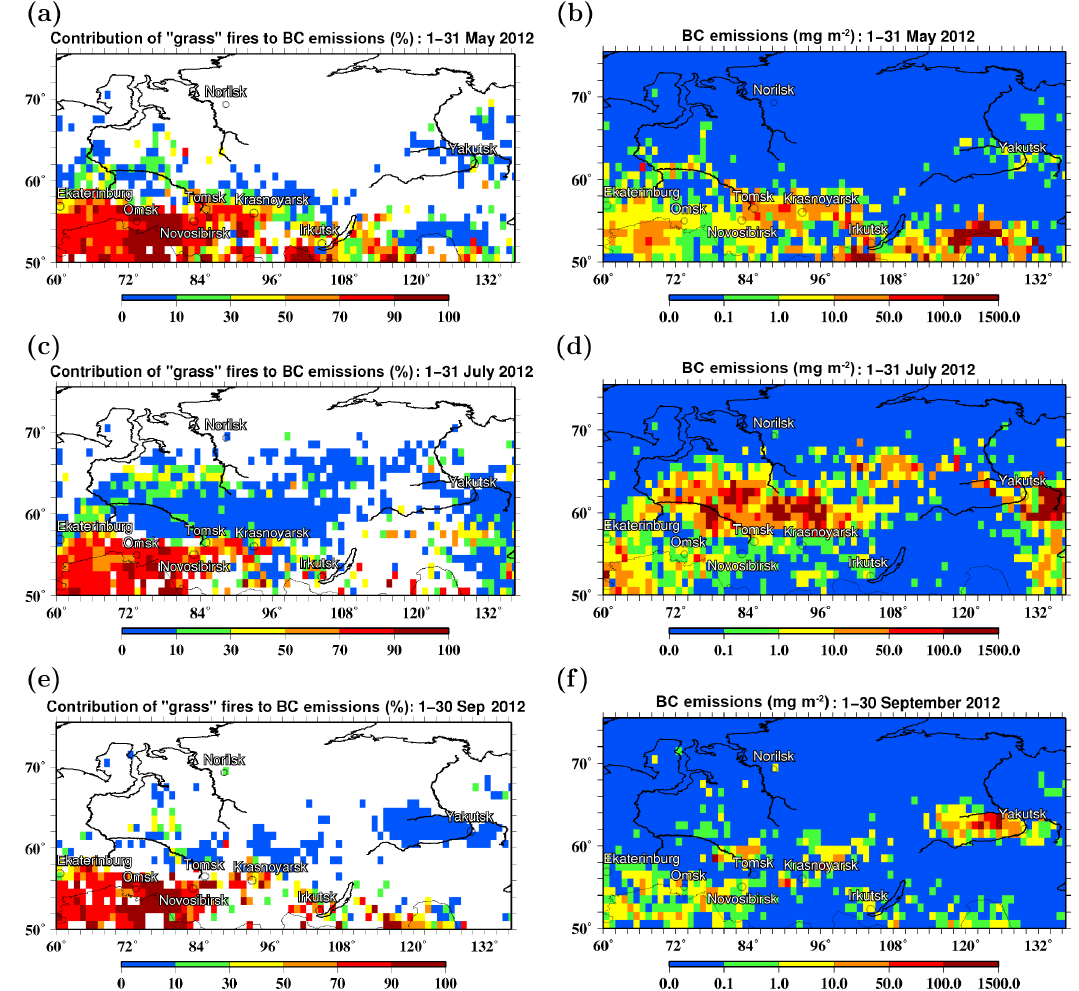
Figure 14. Spatial distributions of the relative contribution of both grassland and agricultural (“grass”) fires to the BB BC emissions integrated over a monthly period (a, c, d) along with the spatial distributions of the corresponding BB BC emission values (b, d, f) for May (a, b) , July (c, d) , and September (e, f) , 2012. The distributions were obtained using Eq. (2) and the optimal estimates of the correction factors, F BC